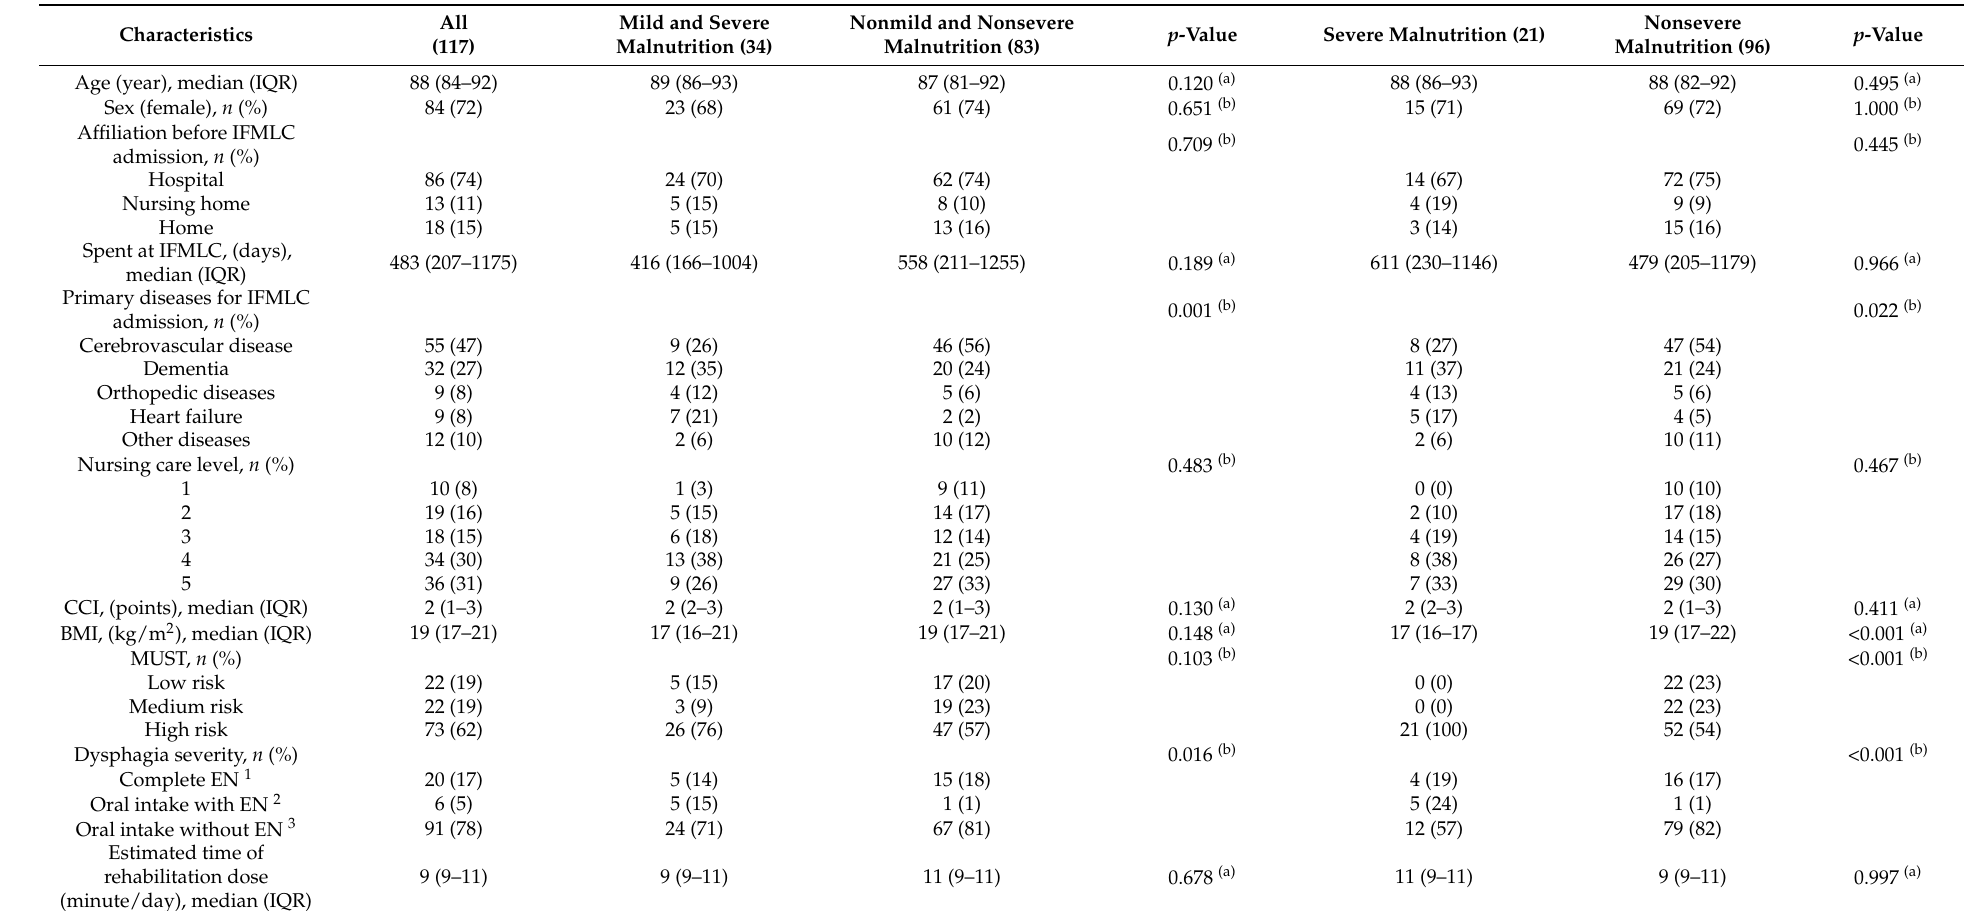
Table 1. Resident characteristics during the survey